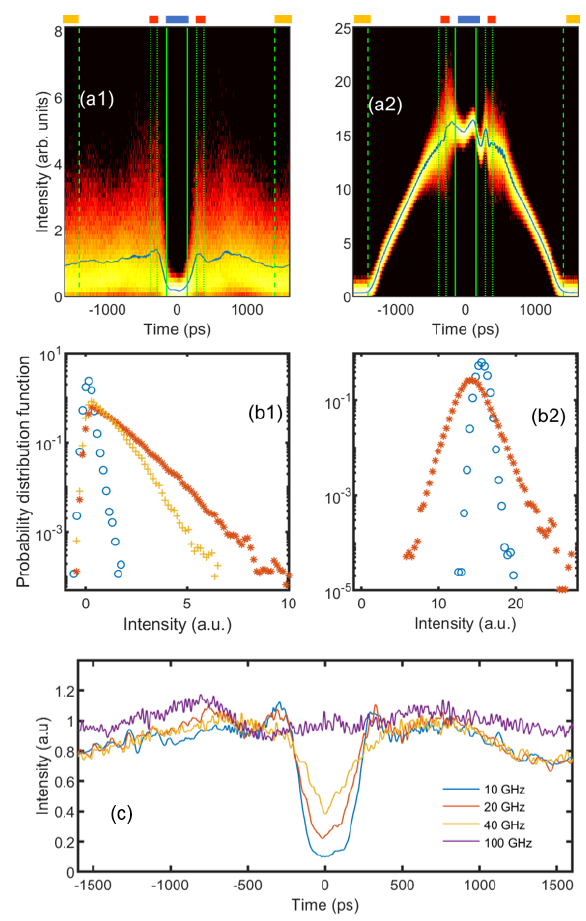
Fig. 2. Impact of the landscape partial incoherence on the vectorial DSWs. (a-b) Experimental results obtained for a pulse -peak power of 3.8 W and a spectral coherence of the probe of 10 GHz. (a) Output intensity profiles recorded for the probe and pulse waves are plotted in panels (a1) and (a2) respectively. (b) Evolution of the pdf in two different temporal sections of the probe and pulse waves (panel b1 and b2 respectively). Statistics for the central part of the probe (blue part in panels (a)) are plotted with blue open circles whereas properties in the lateral bumps (red parts in panels (a)) are plotted with red stars and with yellow crosses for the region outside the temporal pulse extend (yellow part in panels (a)). (c) Impact of the partial incoherence on the probe signal. Output temporal intensity profile of the probe wave after averaging over 1000 shots. Different levels of initial incoherence are compared: 10, 20, 40 and 100 GHz (blue, red, yellow and purple colors,